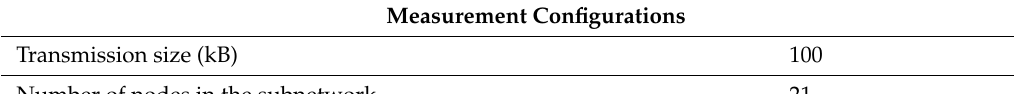
Table 2. Summary of the considered configurations for the evaluation of IP over PLC-PRIME.